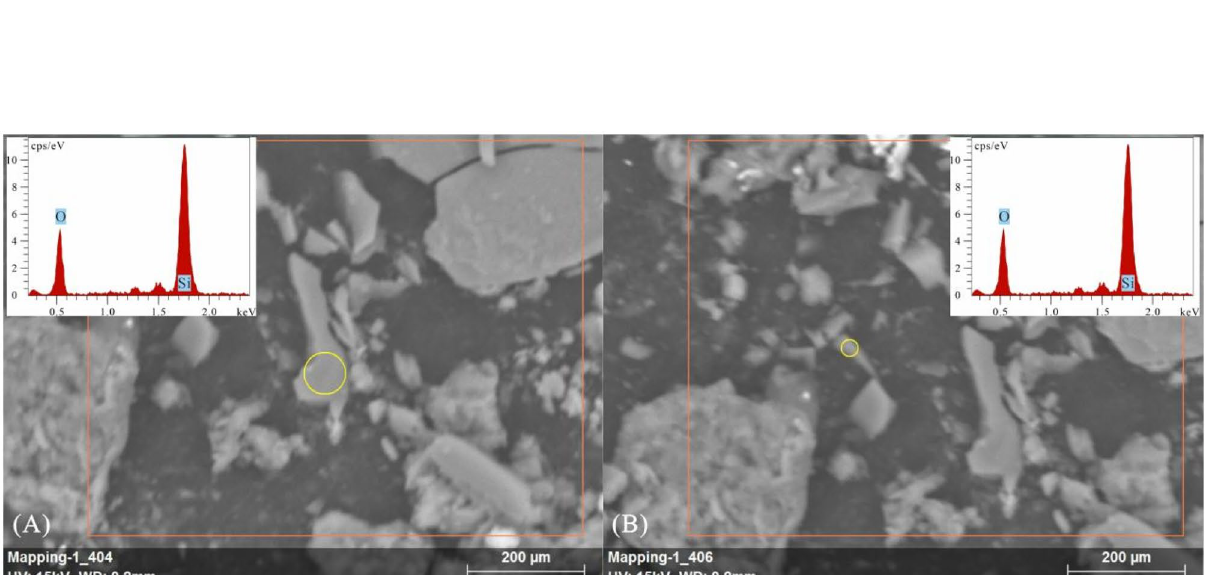
Figure 6. SEM image and EDS data for volcanic glass in the